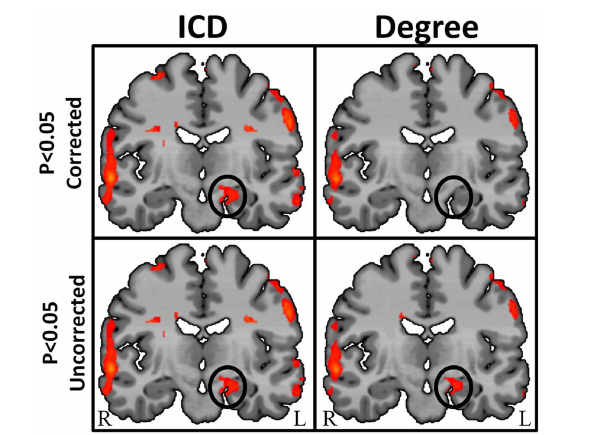
FIGURE 7 | Regions of high intrinsic connectivity for left temporal lobe epilepsy (LTE) patients ( n = 10) shown at different statistical levels . At p < 0.05 corrected (top row) the ICD map (left) highlights significant patterns of increased connectivity in the left hippocampus whereas the degree map (right) does not show significantly different connectivity in this region. At a less stringent statistical threshold (bottom row), the degree map shows the same areas at p < 0.05 uncorrected (right) as the ICD maps (left) at either statistical threshold.This suggests that intrinsic connectivity is capable of detecting abnormal connectivity in regions of epileptogenic tissue and that the ICD approach yields higher sensitivity and